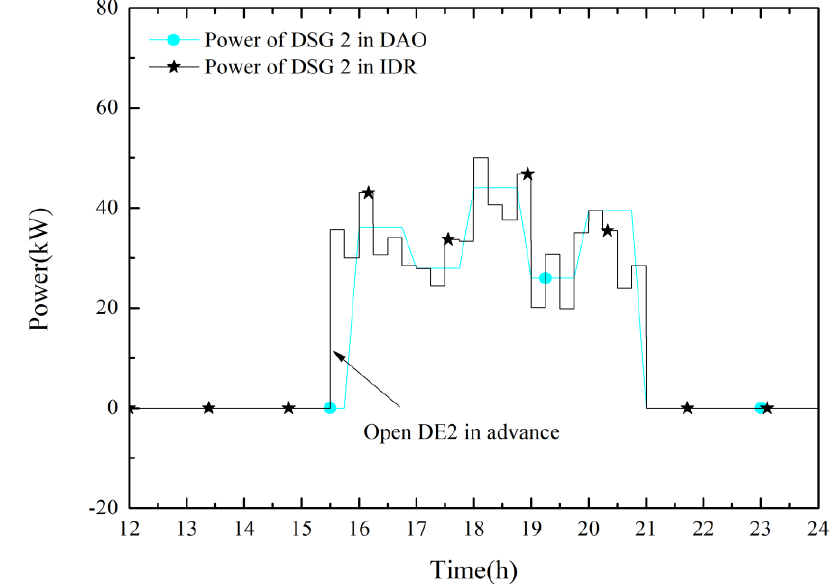
Figure 9. The DSG unit commitment.